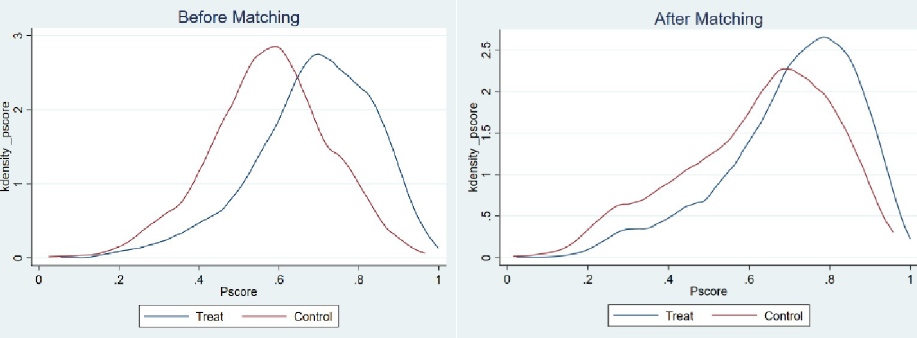
Fig 2. Y1: Comparison of the PS probability values between “rural households who participated in the appraisals” and “rural households who did not participate in the appraisals” before and after nearest neighbor matching.